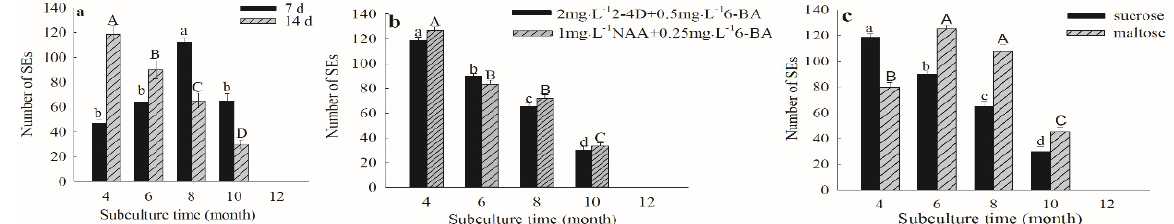
Figure 1. Effects of subculture cycle, hormone ratio, and carbon source on the number of somatic embryos in Pinus koraiensis . ( a ) Number of somatic embryos in different subculture cycles, ( b ) Number of somatic embryos with different hormone ratios, ( c ) Number of somatic embryos with different carbon source typest; Note: Different letters (upper or lower case) in the table indicate significant differences between data columns (Duncan’s multiple range test; p = 0.05).